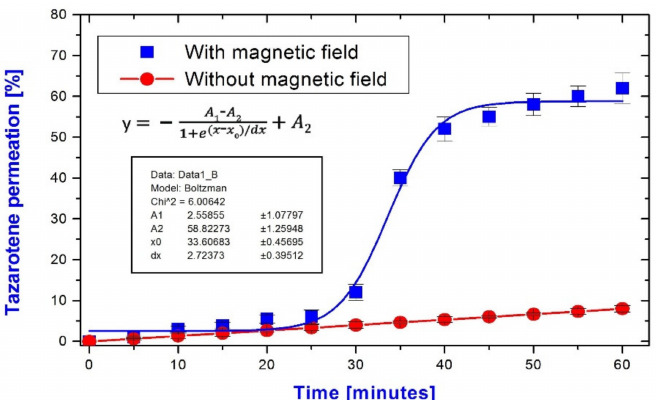
Figure 9. In vitro permeation profile of tazarotene through the abdominal human skin form nanofiber patch and the effect of alternating magnetic field on time course of tazarotene